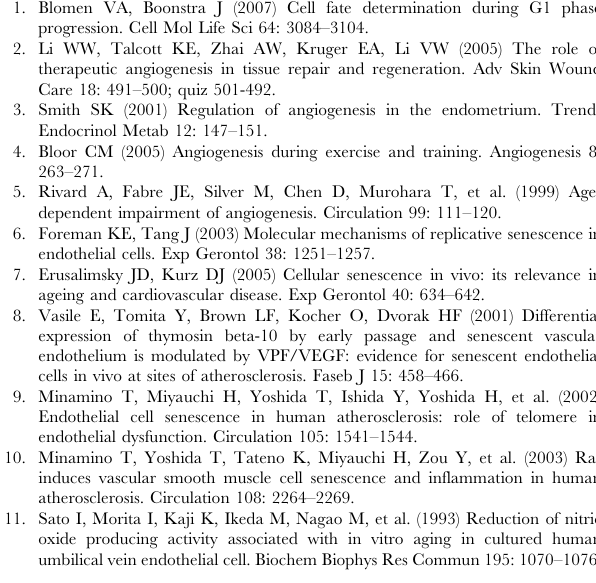
Table S1 List of PCR primers used to create MEOX1 and MEOX2 fusion proteins. Table S2 List of PCR primers used to create the